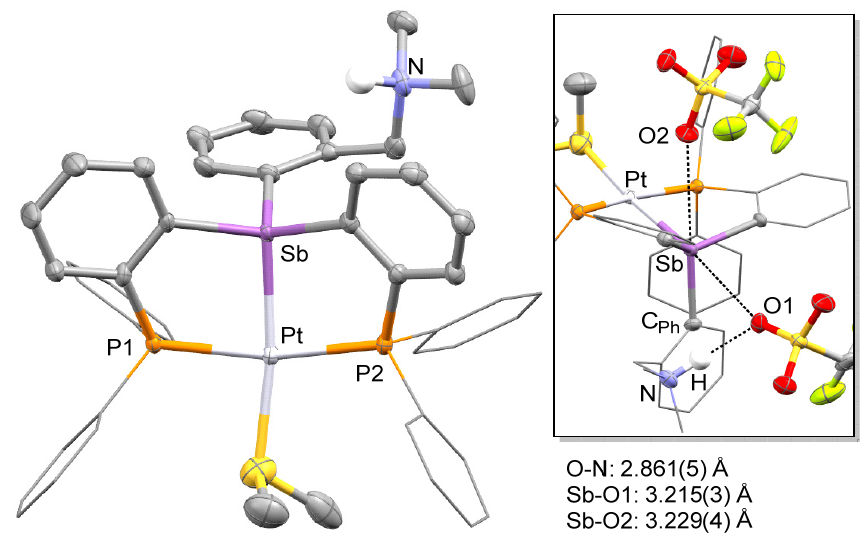
Figure 4. Solid-state structure of complex [ 4 ][OTf] 3 . Thermal ellipsoids are drawn at the 50% probability level. The hydrogen atoms, interstitial solvent molecules, and counteranions are omitted for clarity while the Ph groups are draw as thin lines. The inset shows weak interactions involving the triflate anions along with selected distances. Other relevant metrical parameters can be found in the text.